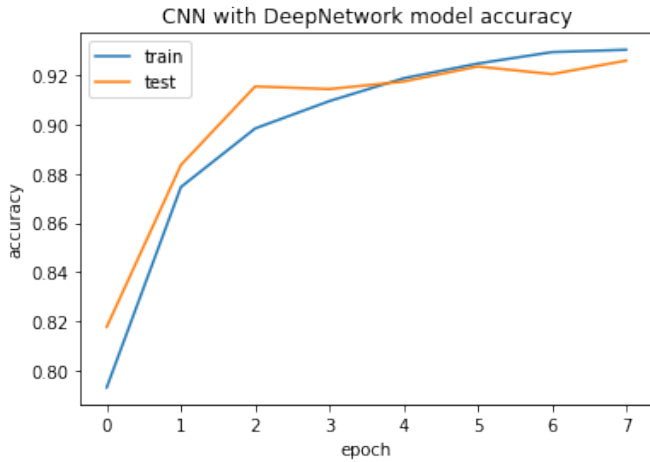
Figure 26. CNN with DeepNetwork model